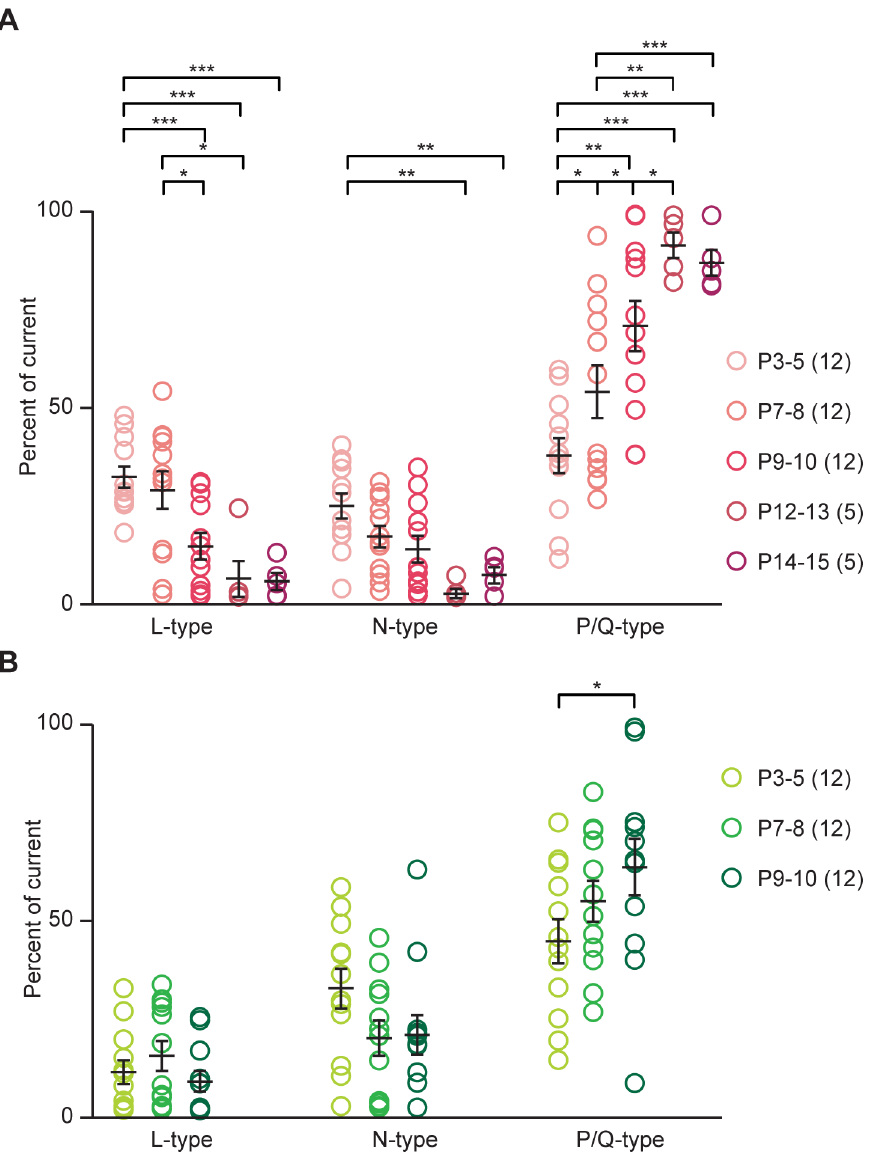
Figure 4. Proportional contribution of VGCC subtypes to neurotransmission between P3 and P15. A ) Percent contribution of L, N and P/ Q-type VGCCs to GABA/gly transmission P3–15 (N for each age group in parentheses). The three VGCCs made significantly different contributions at different ages ([2,123]=14.76, P , 0.0001, 2-way ANOVA; Bonferroni post-tests, * P , 0.05, ** P , 0.005, *** P , 0.0005). B ) Percent contribution of L, N and P/Q-type VGCCs to glutamate transmission P3–10. L and N-types made similar contributions, while P/Q-type made significantly larger contributions at later ages ([2, 99]=60.77, P , 0.001, 2-way ANOVA; Bonferroni post-tests P , 0.05). For ages P3–10, both a GABA/gly and a glutamate component were recorded from each